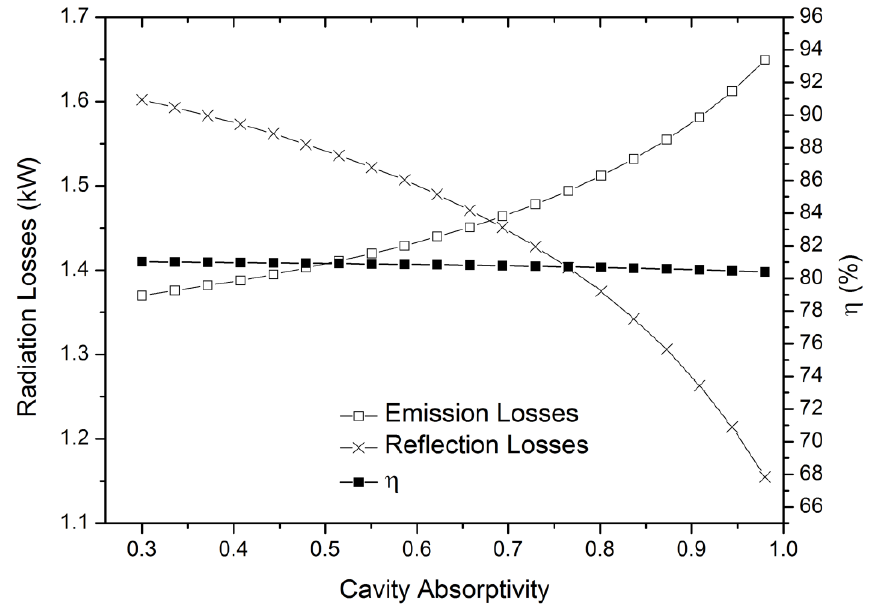
Figure 13. Efficiency and radiation losses varying cavity absorptivity (solar source: 28 kWt).